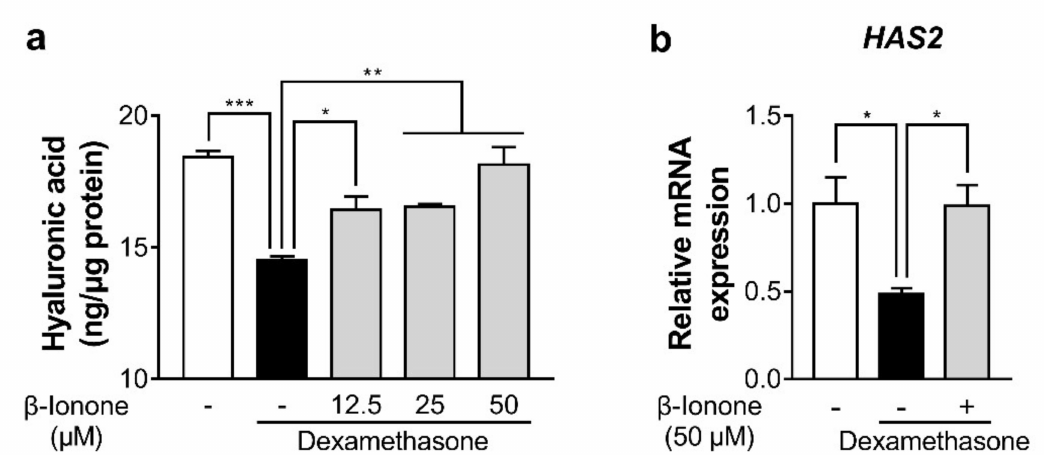
Figure 3. Effect of β -ionone on hyaluronic acid synthesis in human dermal fibroblasts. The cells were cultured with either vehicle (shown as “-”) or three concentrations of β -ionone (12.5, 25, or 50 µ M (shown as “+”)) and dexamethasone (1 µ M) for 24 h. ( a ) Hyaluronic acid content was measured in the culture medium of dermal fibroblasts, and ( b ) mRNA expression levels of hyaluronic acid synthase 2 ( HAS2 ) were determined in the cells. Values are shown as mean ± standard error of the mean (SEM) of three experiments. Statistical significance is expressed as follows: * p < 0.05, ** p < 0.01, *** p < 0.001.